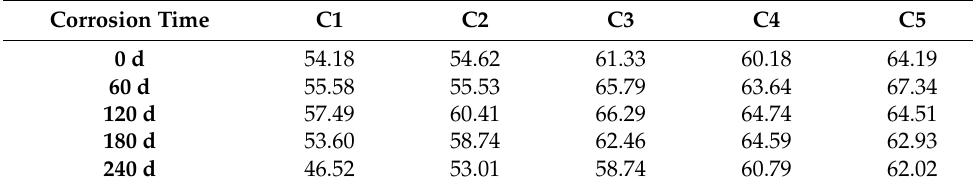
Table 3. Compressive strength of concrete (unit: MPa). Corrosion